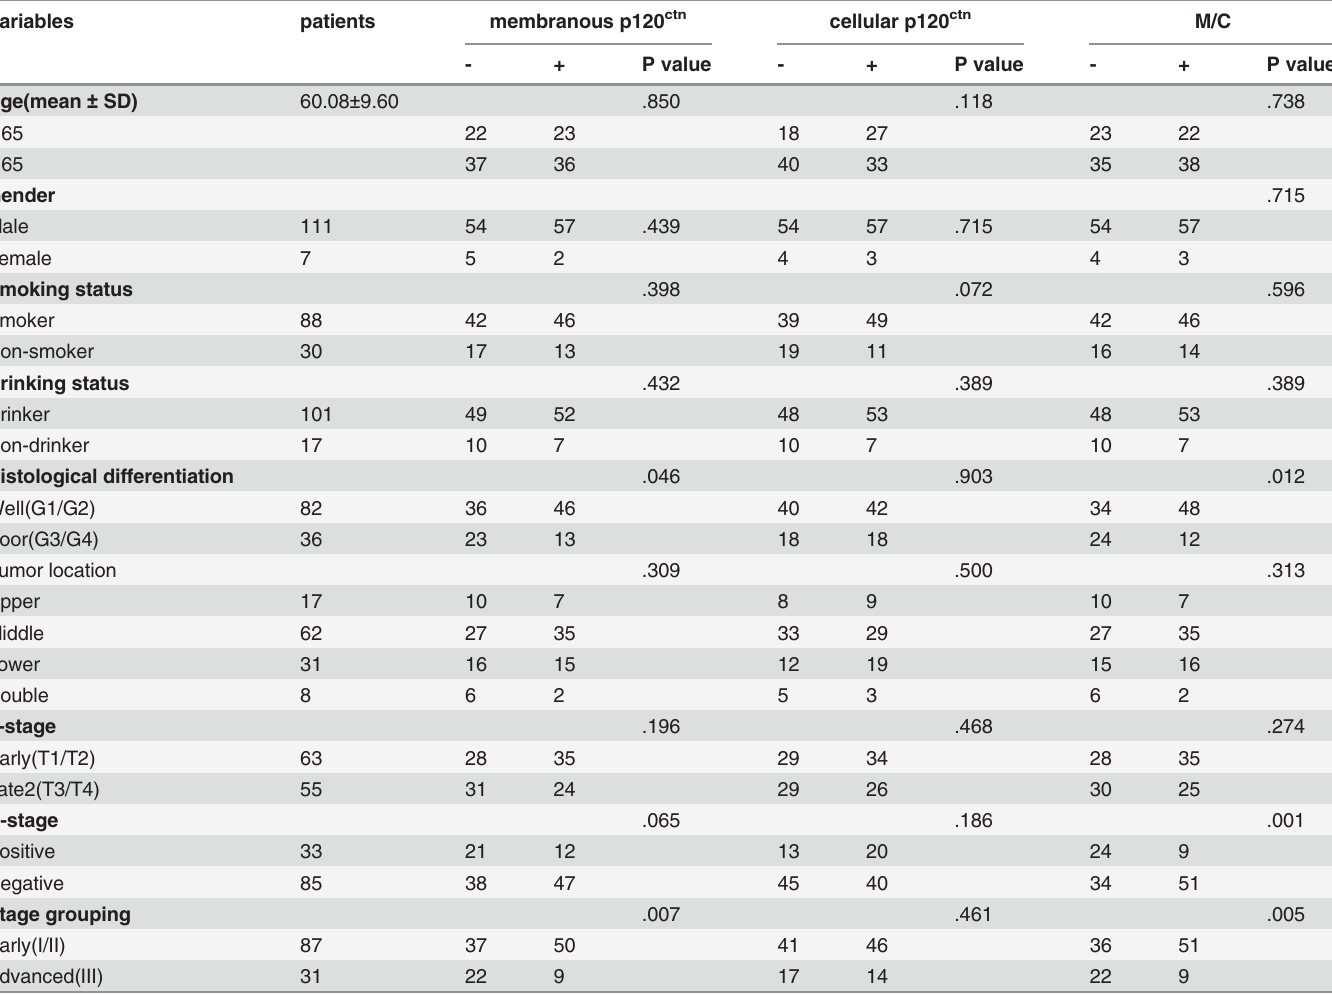
Table 1. Relationship between p120ctn localization and histological and clinical